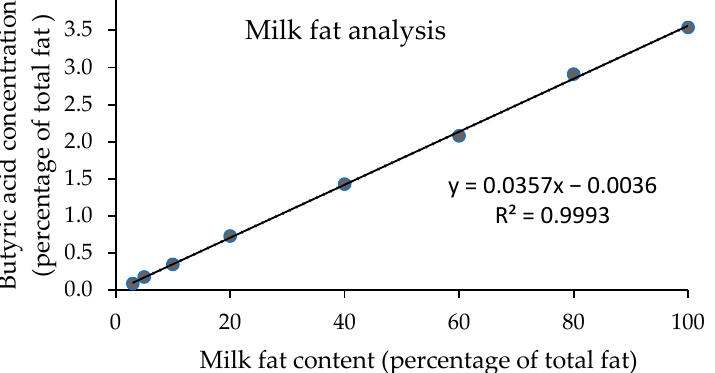
Figure 3. The standard calibration graph shows the relationship between butyric acid concentration and milk fat content.